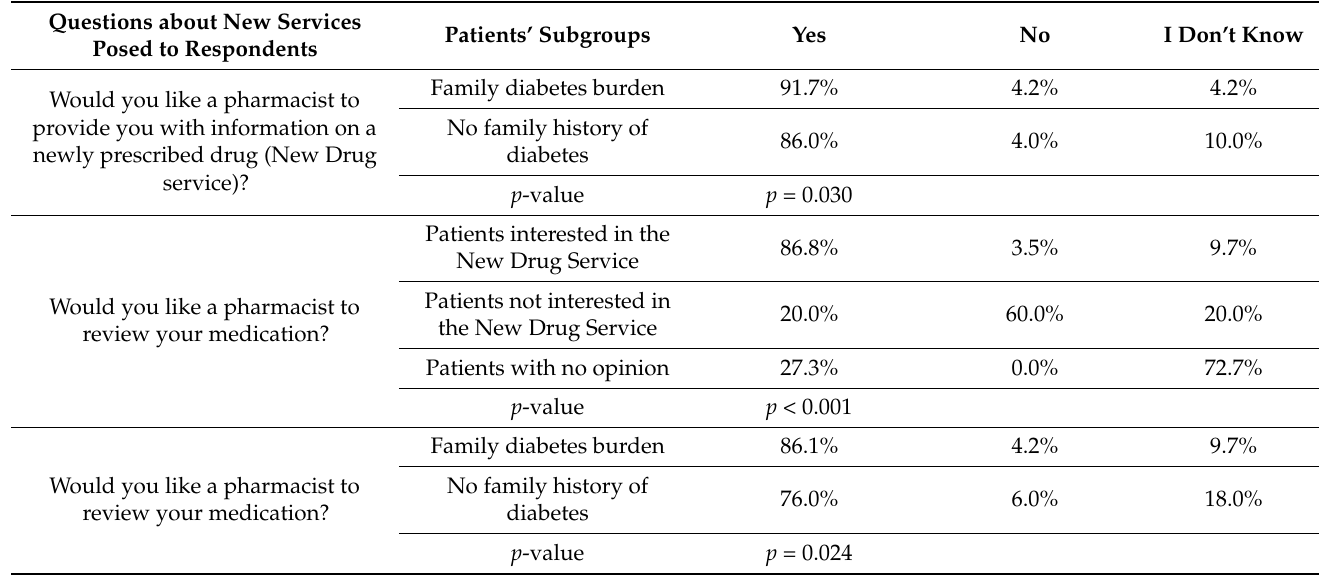
Patients’ interest in drug-related services—only statistically significant differences between